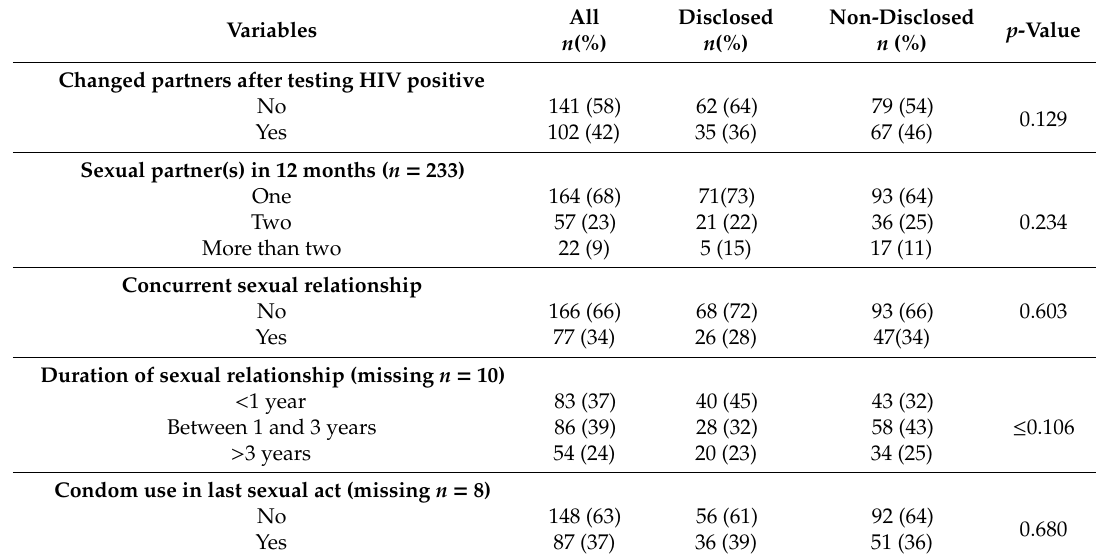
Table 2. Sexual behaviour and relationship characteristics of YPLHIV by disclosure status ( n =